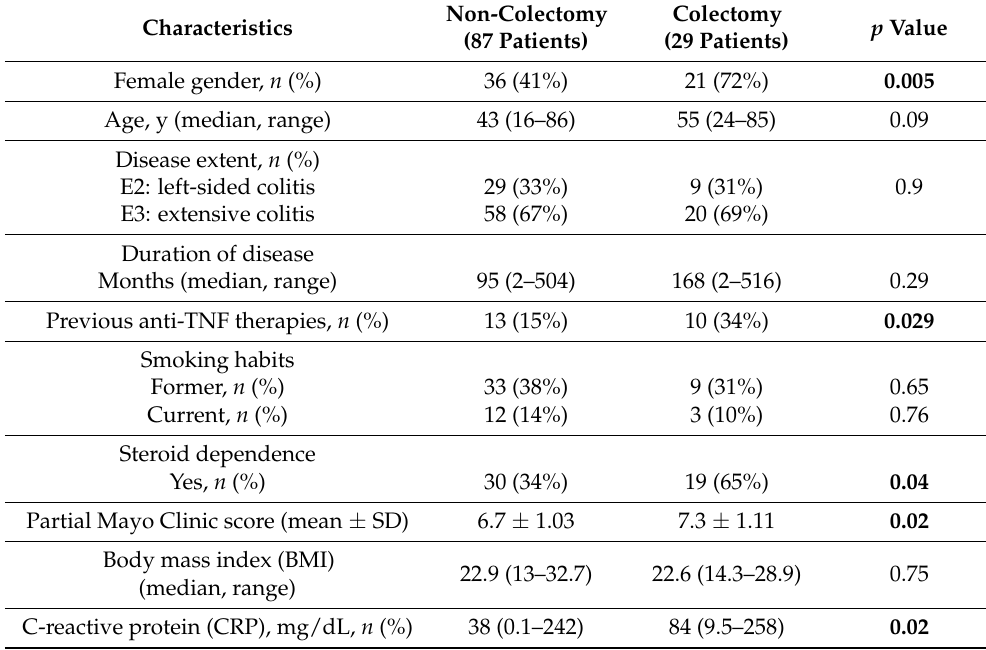
Table 1. Comparison of clinical parameters and laboratory and radiological data between the non- colectomy and colectomy